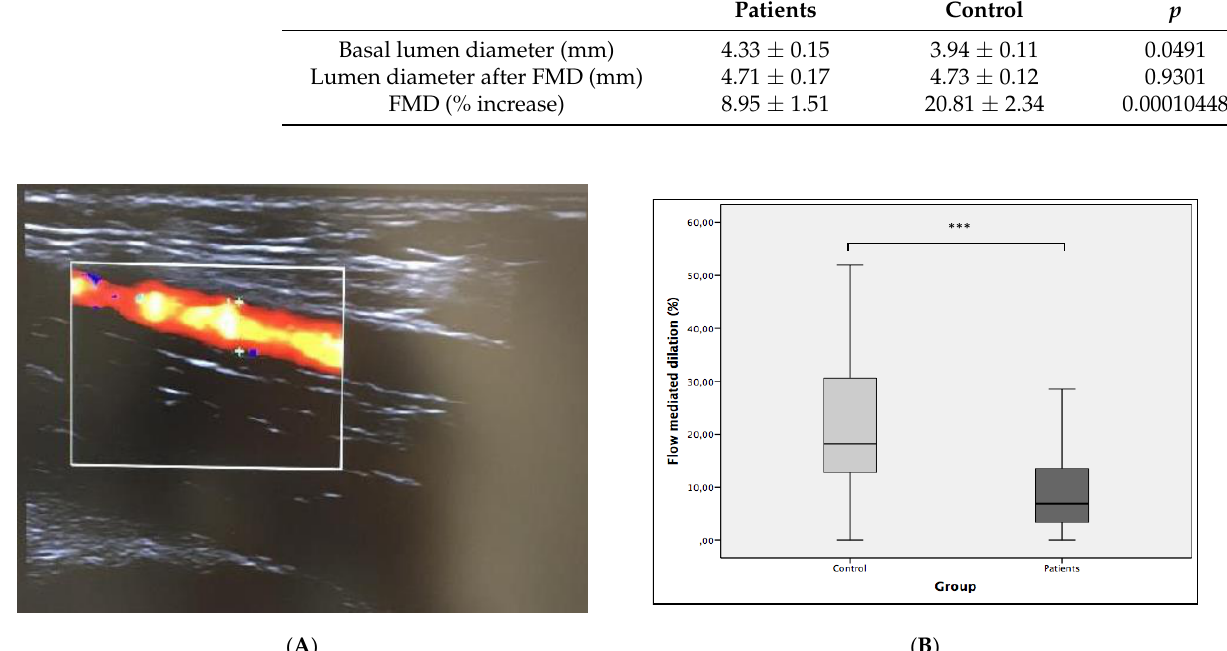
Figure 1. ( A ) Eco doppler capture of brachial artery. ( B ) Comparative analysis of flow-mediated dilation (FMD%) between groups. Statistical differences were calculated with t test. *** p =0.0001.